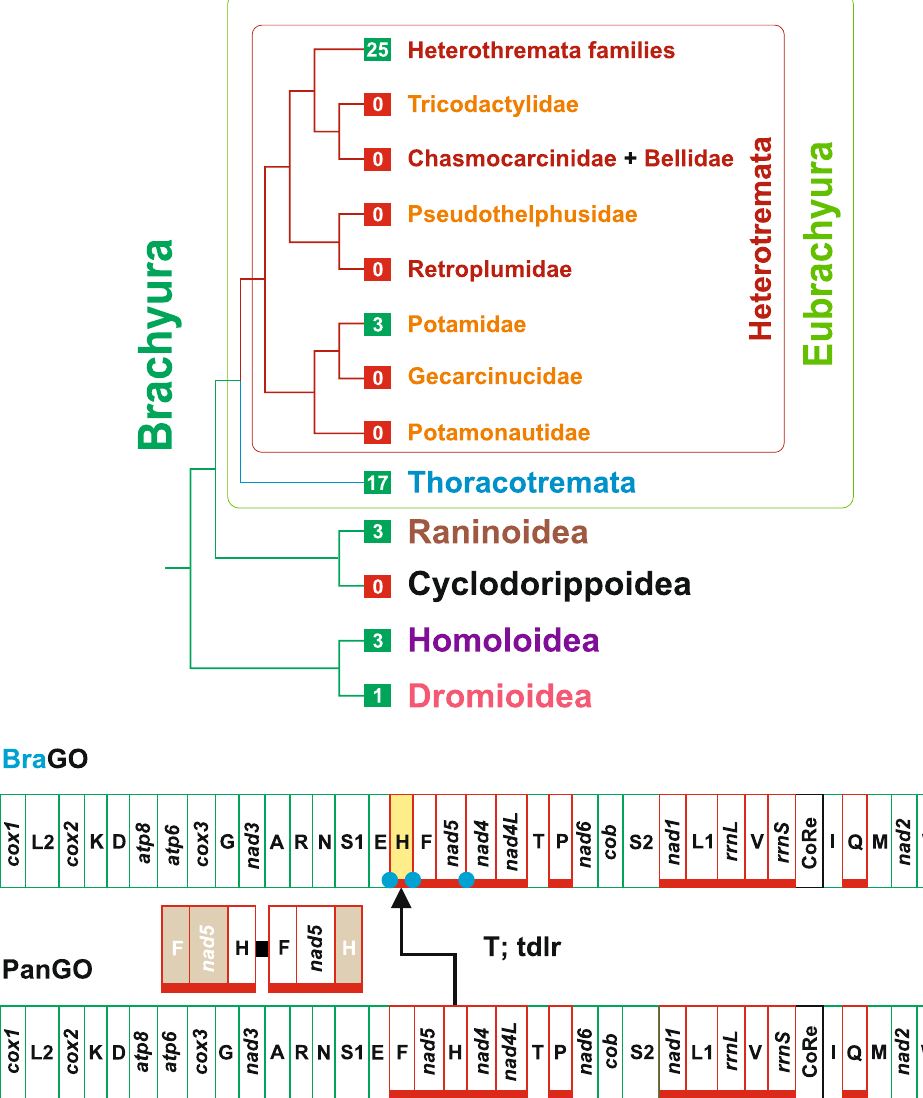
Figure 1. Phylogenetic relationships among major Brachyuran clades and BraGO vs PanGO. The tree depicts the phylogenetic relationships among the major Brachyura lineages cited in the main text. The values in the green/red box refer to the full-length mtDNAs available for that lineage. The taxa names are coloured according to the current placement of taxa themselves within the major Brachyuran groups ( e . g . all families belonging to fresh water crabs are in orange). The genomic transformation from PanGO to BraGO is provided below the tree. PanGO is linearized starting from cox1 . The genes encoded on the α -strand (orientation from right to left in Fig. 1) are green-boxed, while those encoded on the β -strand (orientation from left to right in Fig. 1) are underlined and red-boxed. Nomenclature: atp6 and atp8 : ATP synthase subunits 6 and 8; cob : apocytochrome b; cox1-3 : cytochrome c oxidase subunits 1–3; nad1-6 and nad4 L : NADH dehydrogenase subunits 1–6 and 4 L; rrnS and rrnL : small and large subunit ribosomal RNA (rRNA) genes; X: transfer RNA (tRNA) genes, where X is the one-letter abbreviation of the corresponding amino acid, in particular L1 (CTN codon family) L2 (TTR codon family), S1 (AGN codon family) S2 (TCN codon family); CoRe: Control Region. T: transposition event. Tdrl: tandem duplication random loss mechanism producing the observed rearrangement. TrnH , that changed its position relative to PanGO, through a transposition event, is shown with a yellow background. Conversely, the passively-shifted genes are figured with their original background (see Methods section). The extra copy of every gene that is lost in the genomic rearrangement is figured with a light brown background. A blue circle marks an intergenic spacer present in a position associated to genomic